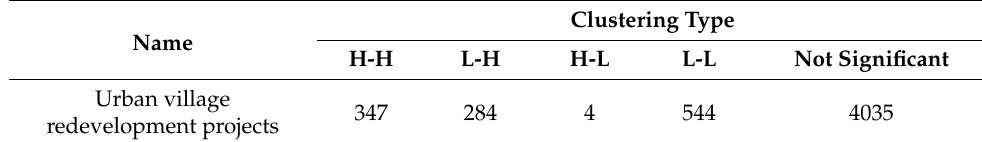
Table 3. Results of Local Moran’s I.